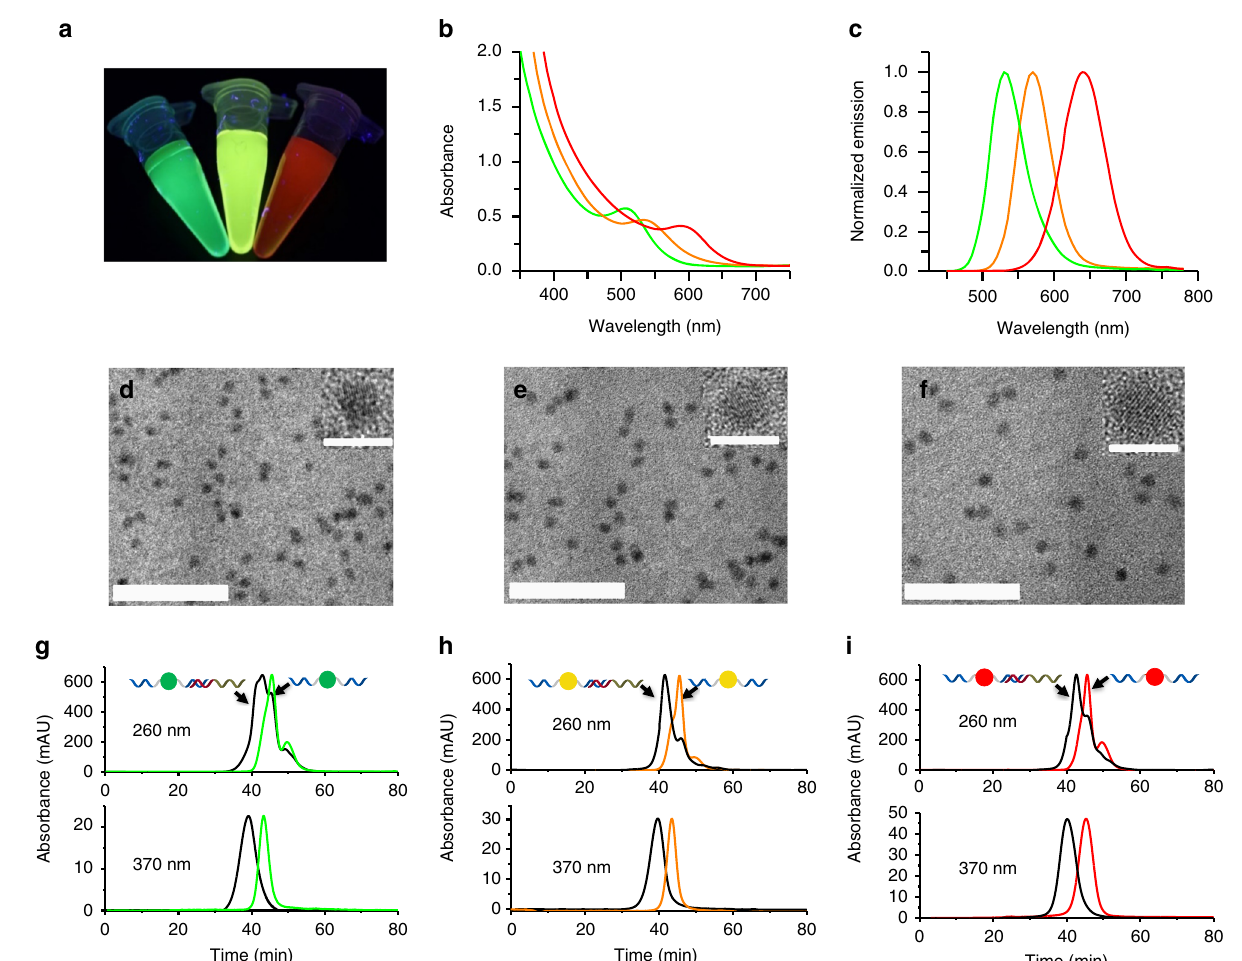
Fig. 2 Optical, morphological, and hybridization properties of DNA-functionalized QDs. a Photograph of the three types of QDs upon illumination with UV light. b Absorption spectra of QDs. c Normalized fl uorescence spectra of QDs. TEMs of the DNA-functionalized green ( d ), yellow ( e ), and red ( f ) CdTe QDs. Scale bars are 50 nm (lower) and 5 nm (upper). g – i High-performance liquid chromatography characterization of DNA-functionalized QDs and the hybridization of template with complementary